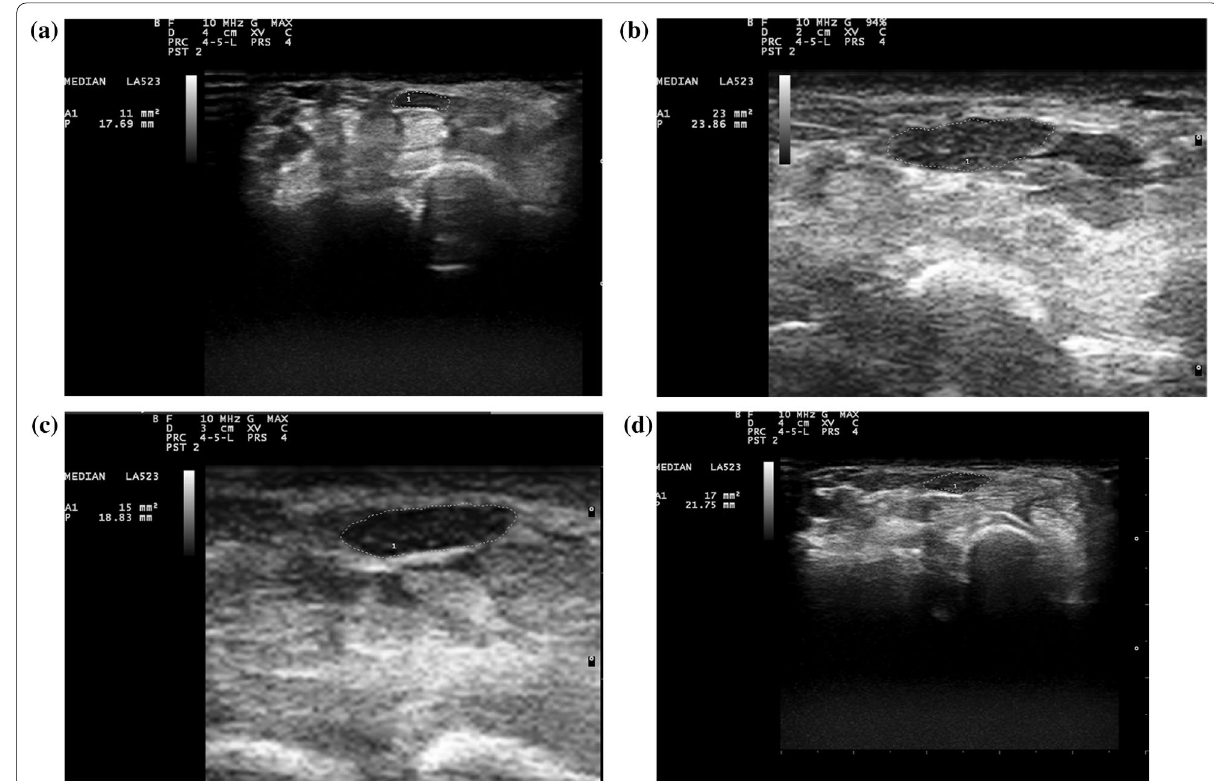
Fig. 1 Neurosonography figures showing anatomical and cross-sectional area measurements. a Right median nerve, BCTQ 27. b Left median nerve, BCTQ 21. c Right median nerve, BCTQ 38. d Right median nerve, BCTQ